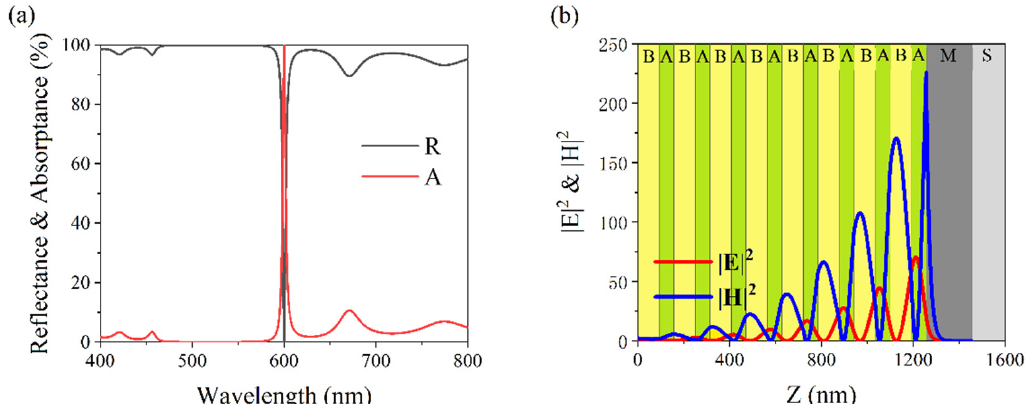
Figure 4. ( a ) Simulated reflection (solid black line) and absorption (solid red line) spectra of (BA) 8 MS. The parameters are: d A = 63.2 nm, d B = 93.8 nm, d M = 200 nm. ( b ) Simulated intensities of |E| 2 (solid red line) and |H| 2 (solid blue line) in (BA) 8 MS at an absorption wavelength of 600 nm.